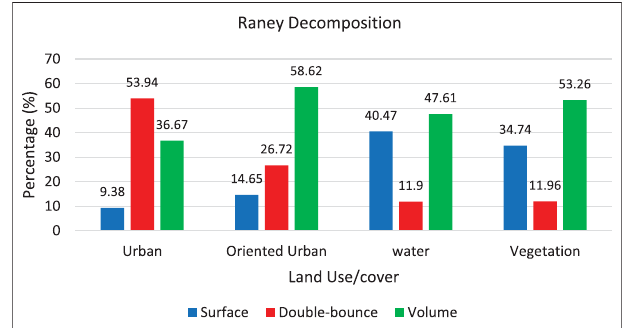
FIGURE 5 | Scattering response for urban, oriented urban, and water (smooth) scatterer obtained from Raney decomposition.